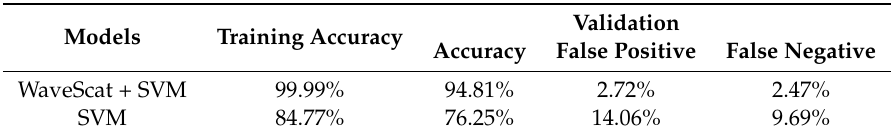
Table 3. Accuracy and confusion results of vertical traces (noisy signals) with or without wavelet scattering networks in the machine learning model.